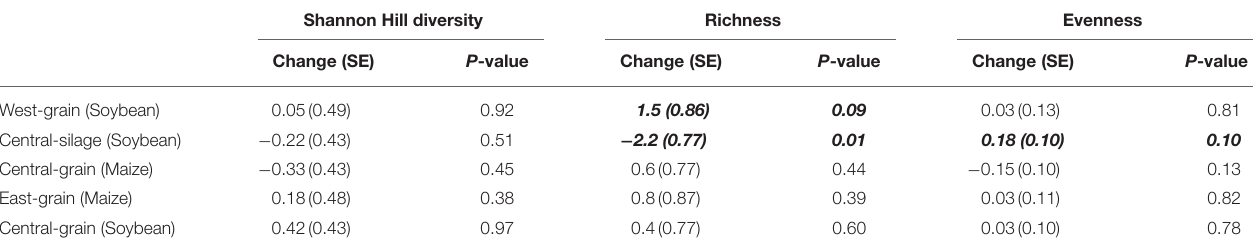
TABLE 4 | Estimated changes, standard errors (SE), and p -values for models of changes in diversity, richness, and evenness for each trial. Shannon Hill diversity Richness Evenness Change (SE) P -value Change